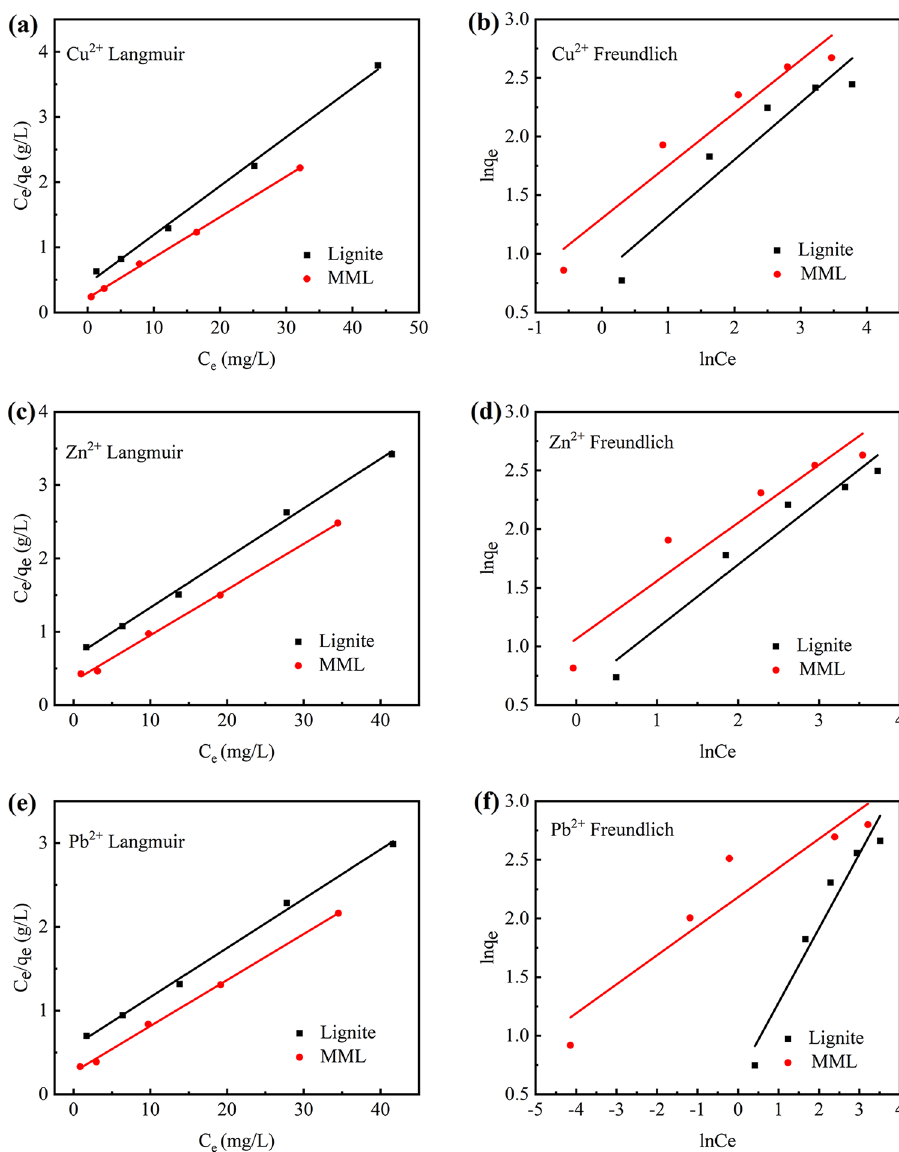
Figure 3. Linear plots of adsorption isotherms of heavy metal ion adsorption on different samples: lignite; MML. ( a ) Cu 2+ Langmuir; ( b ) Cu 2+ Freundlich; ( c ) Zn 2+ Langmuir; ( d ) Zn 2+ Freundlich; ( e )Pb 2+ Langmuir; ( f ) Pb 2+ Freundlich.